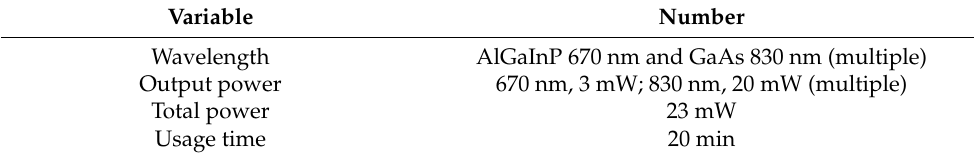
Figure 6. Laser irradiation of rabbits. ( A ) A low-level laser device was used at the following wavelengths and powers: AlGaInP 670 nm, 3 mW and GaAs 830 nm, 20 mW. ( B ) Low-level laser therapy was applied to five rabbits (G4) through the nostrils for 20 min for 7 days. Table 1. Laser specifications used in the present study.